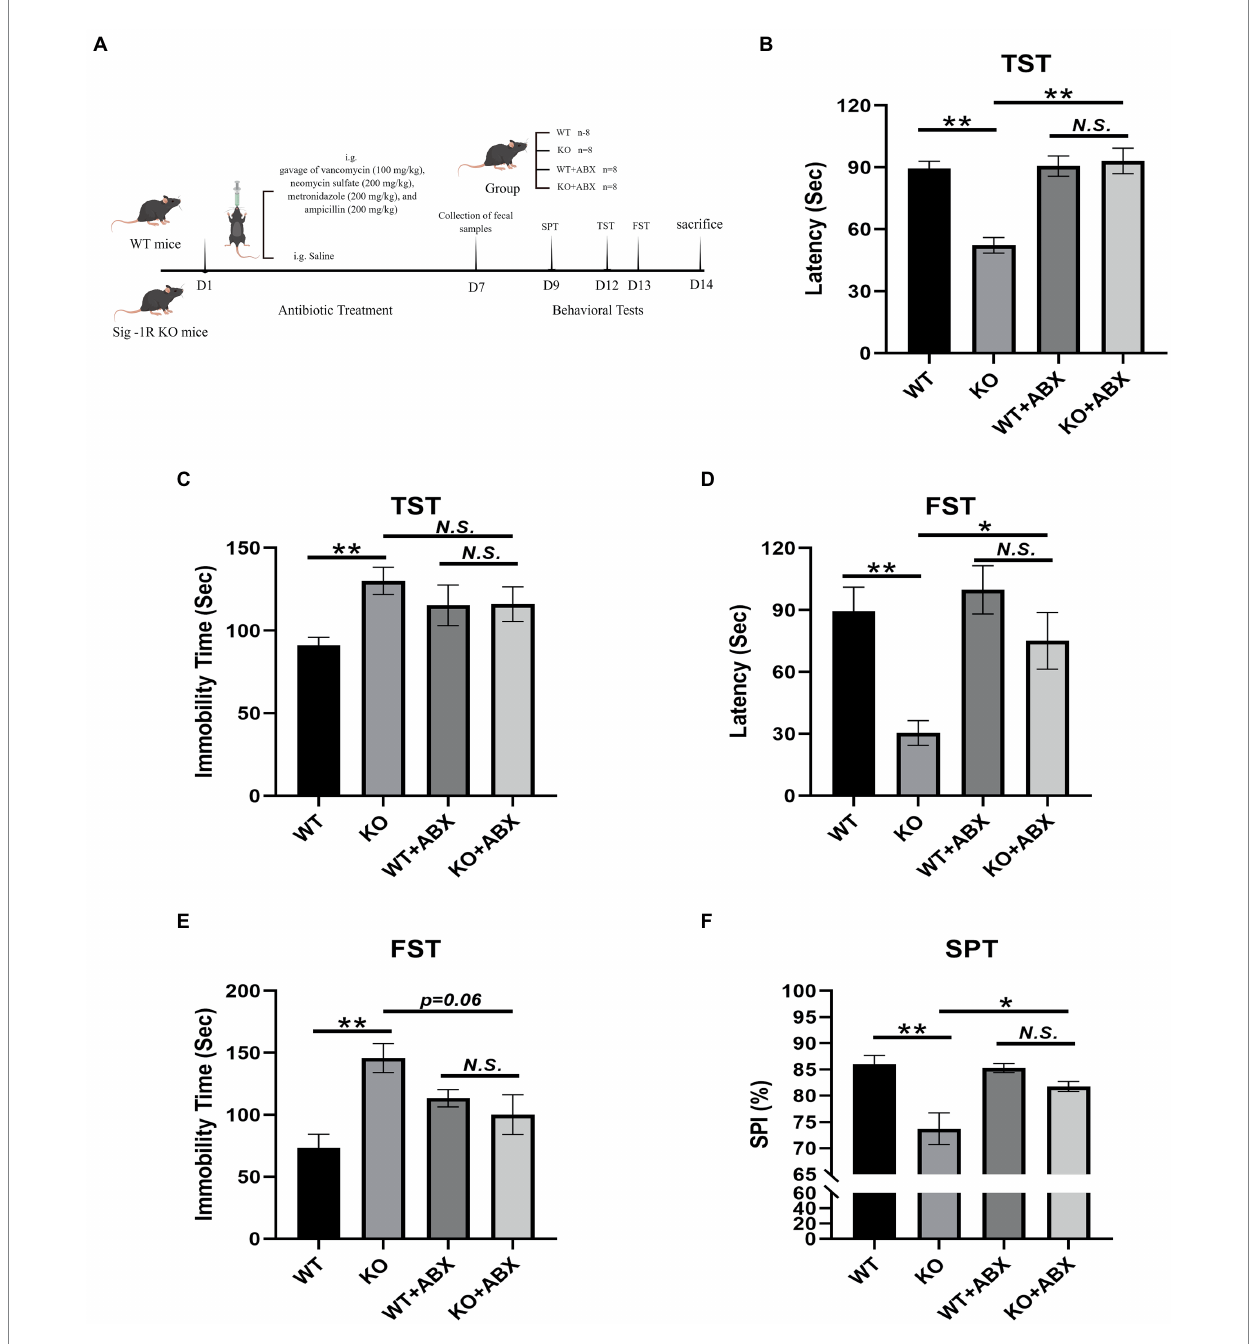
FIGURE 1 Antibiotic treatment reverses Sig-1R knockout-induced depression-like behaviors. (A) The ABX treatment flowchart by Figdraw. (B) Latency (s) to immobility in the TST [For ABX treatment, F (1, 13) = 11.50, p = 0.0048, two-way ANOVA]. (C) Immobility time (s) in the TST [For ABX treatment, F (1, 13) = 6.068, p = 0.0285, two-way ANOVA]. (D) Latency (Sec) to immobility in the FST [For ABX treatment, F (1, 13) = 5.950, p = 0.0298, two-way ANOVA]. (E) Immobility time (s) in the FST [For ABX treatment, F (1, 13) = 13.37, p = 0.0029, two-way ANOVA]. (F) The sucrose preference index (SPI) in the SPT [For ABX treatment, F (1, 10) = 37.09, p = 0.0001, two-way ANOVA]. ** p < 0.01. * p < 0.05. N.S.: not significant. WT, n = 8; KO, n = 8; WT + ABX, n = 6; and KO + ABX, n =